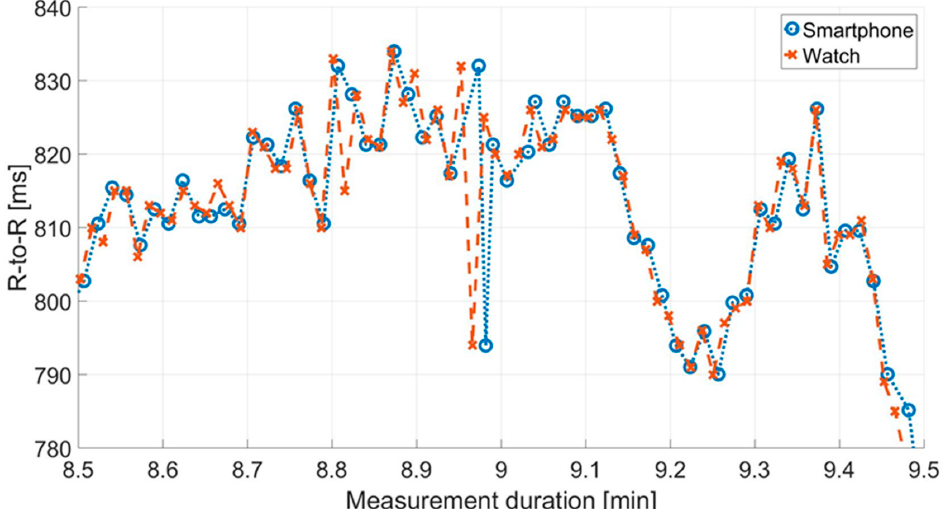
Figure 6. Extract of simultaneous RR interval (R-to-R) (ms) measurements for Cow I during 60 s of recording after outlier removal and but before interpolation acquired with the smartphone IoTool application and Polar watch V800.